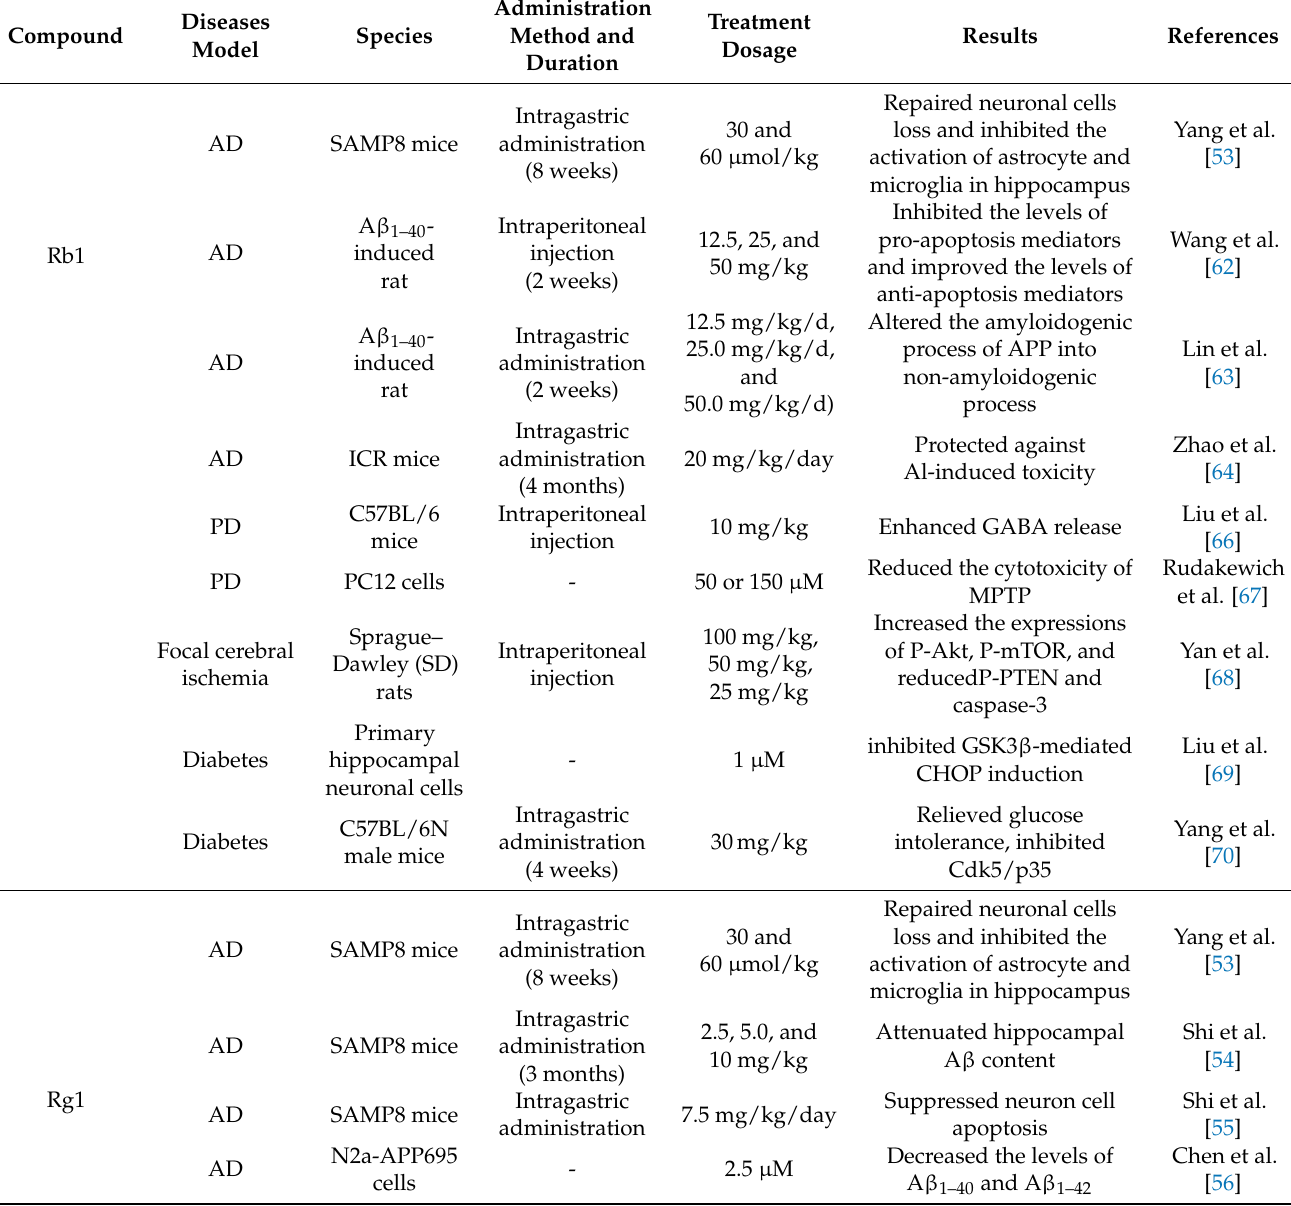
Table 3. Summary of anti-CI ginsenosides in experimental